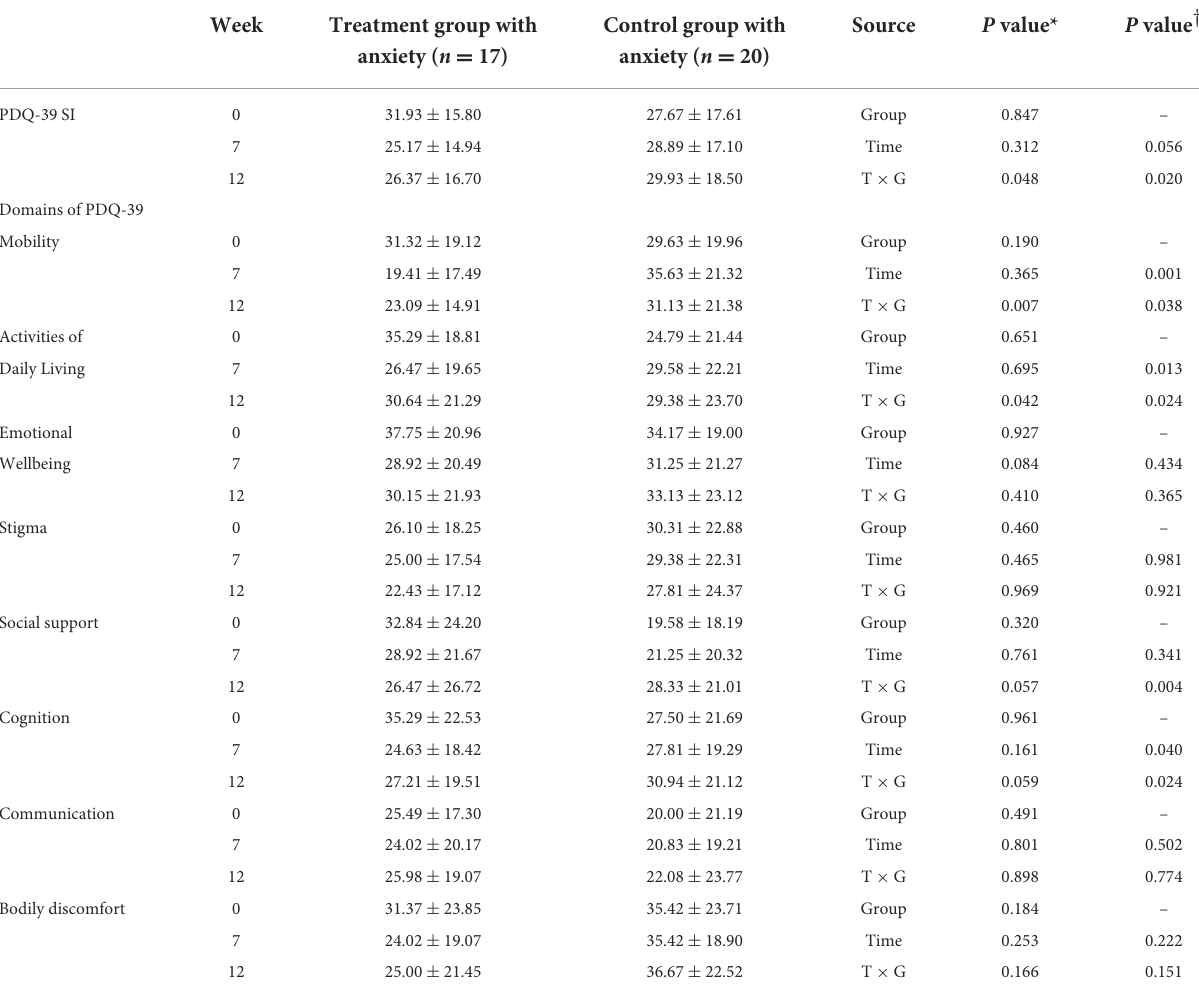
TABLE 8 Comparison PDQ-39 domains and summary index between groups with anxiety. Week Treatment group with Control group with Source P value* P value † anxiety ( n = 17) anxiety ( n = 20) PDQ-39